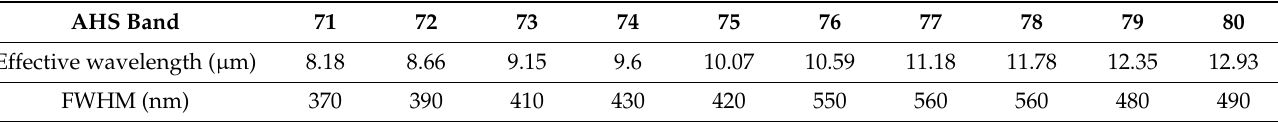
Table 1. Effective wavelength and FWHM of the different AHS spectral thermal bands. AHS